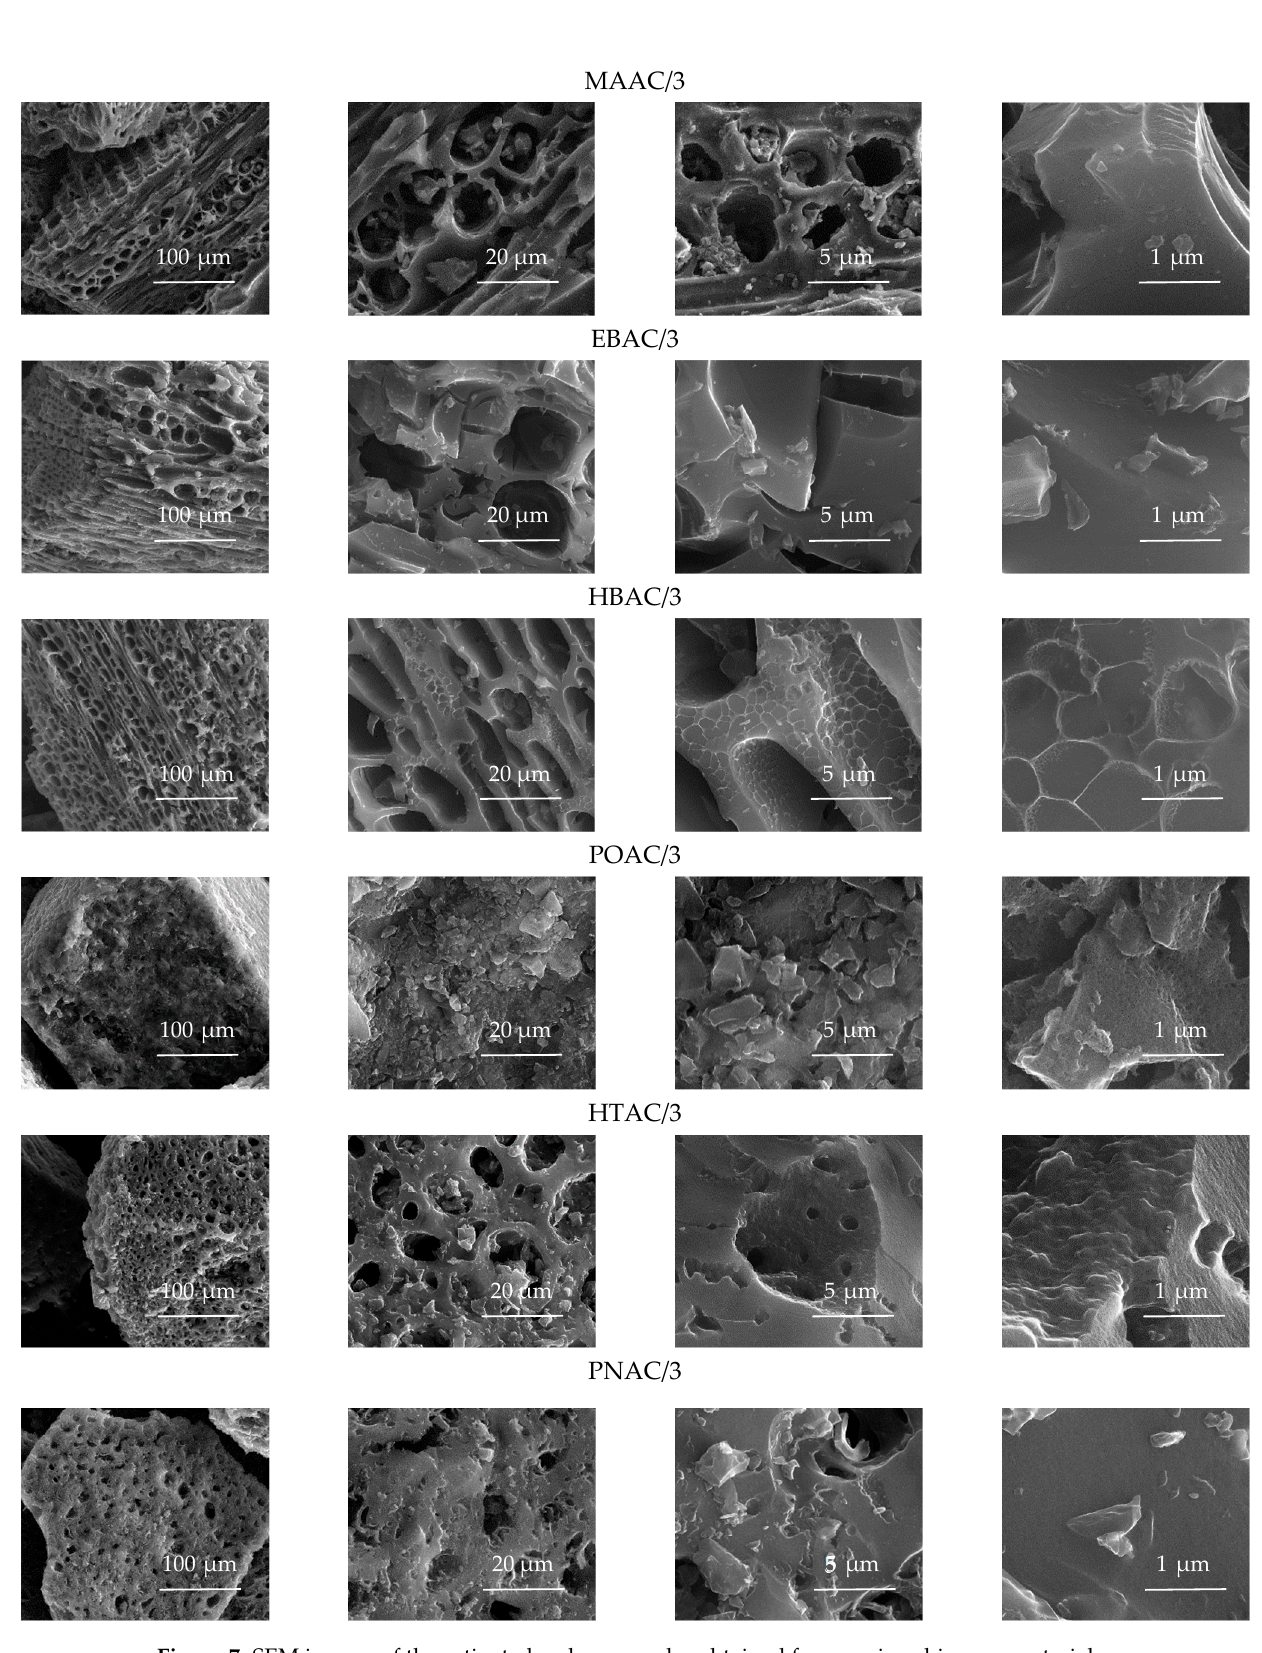
Figure 7. SEM images of the activated carbon samples obtained from various biomass materials. The structures of the activated carbons obtained from nut shells—e.g., pistachio nut shells (POAC/3), hazelnut shells (HTAC/3), and pecan nut shells (PNAC/3)—were defi ‐ nitely different. At first glance, in comparison with the activated carbons obtained from